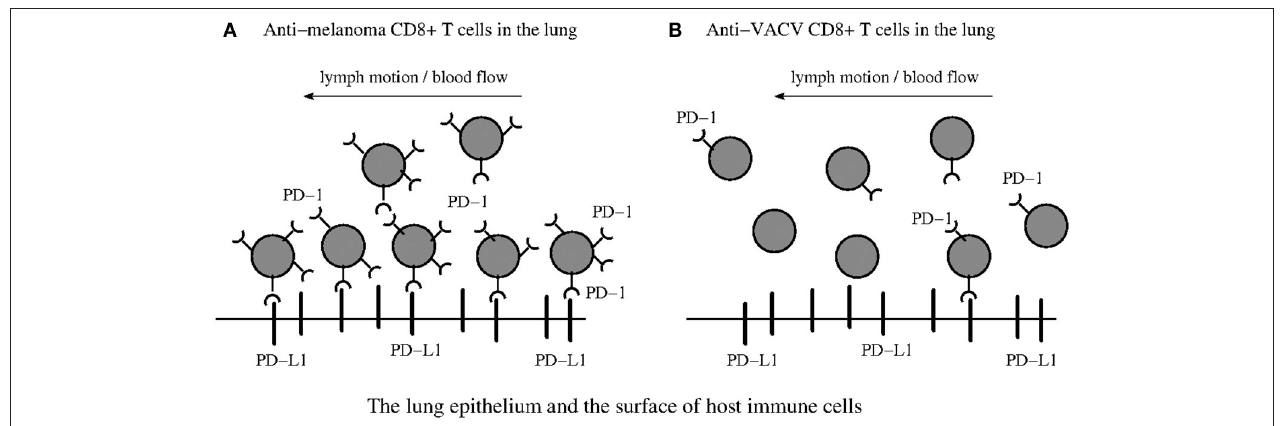
FIGURE 4 | PD-1:PD-L1 induced paralysis of the anti-tumor exhausted CD8+ T cells in the infected site. (A) Suggests that anti-melanoma T EFF cells become paralyzed in the infected lung. In contrast, (B) suggests that anti-VACV T EFF studied in Kohlhapp et al. (1) can freely enter and leave the infected lung with the lymph motion and blood flow due to the lack of large amounts of PD-1 receptors on their surface. The immune suppressive environment (4) induced by inflammation in the infected lung is caused by multiple interactions between PD-1 receptors, expressed in large quantities on the surface of the anti-melanoma T EFF , and the PD-L1 ligands expressed in large quantities on the surface of various host immune cells (macrophages, DCs, and MDSCs) and the epithelium (29).